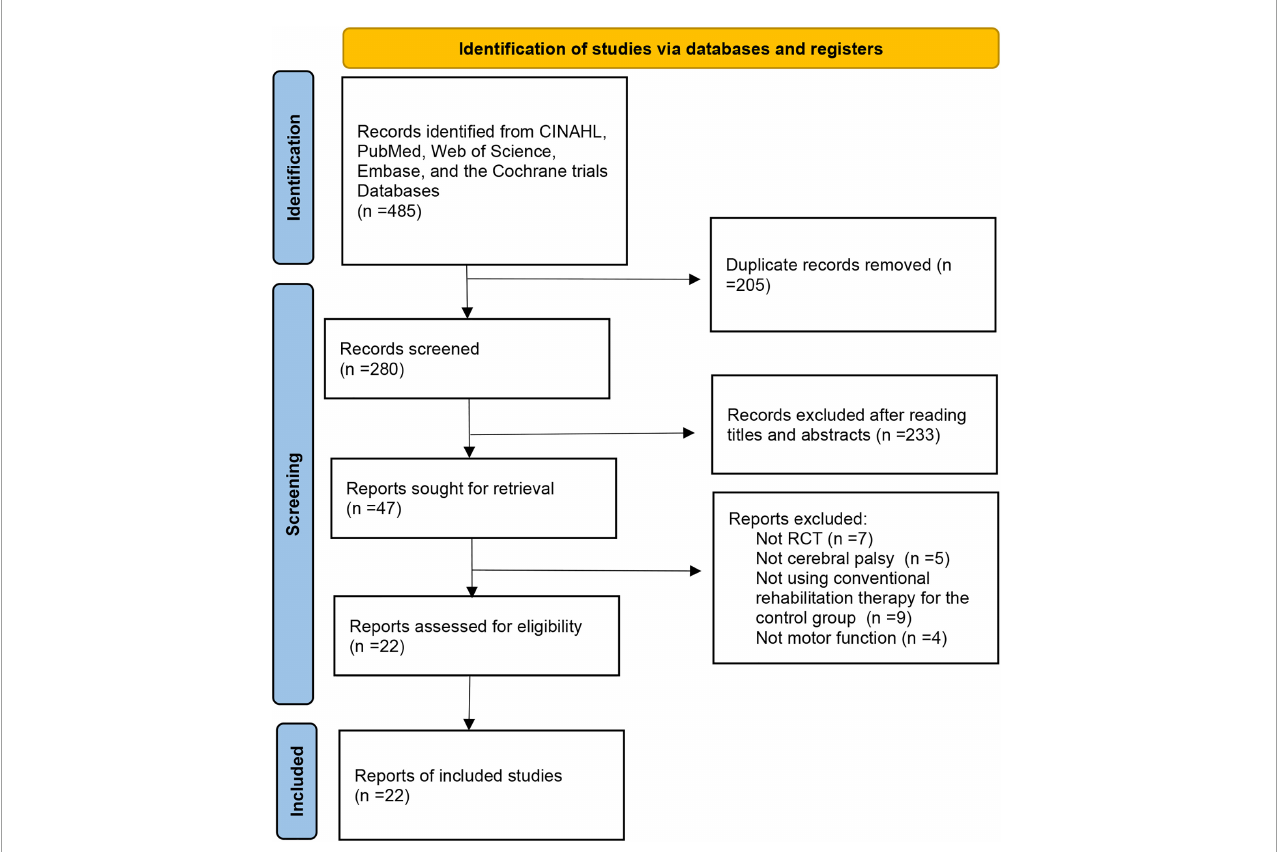
FIGURE1 Flowchart of the process of literature search and extraction of studies meeting the inclusion